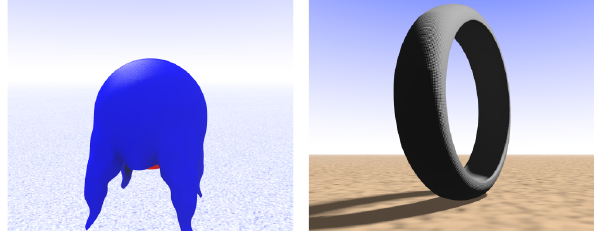
Figure 16. Two models with friction and contact using Chrono ::Flex plate elements: a cloth hanging on a sphere and a closed contour shaped like a tire.